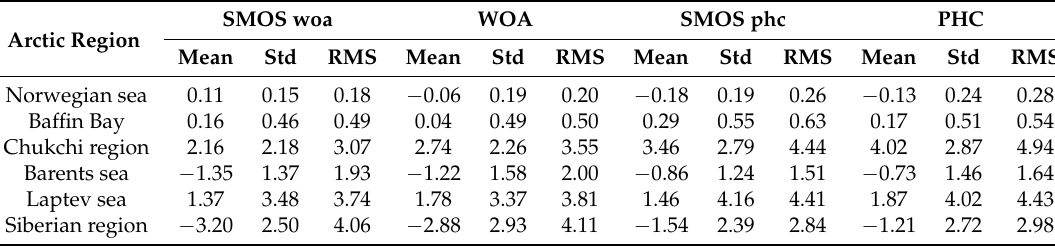
Table 1. Statistics in the comparison of SMOS SSS with TARA